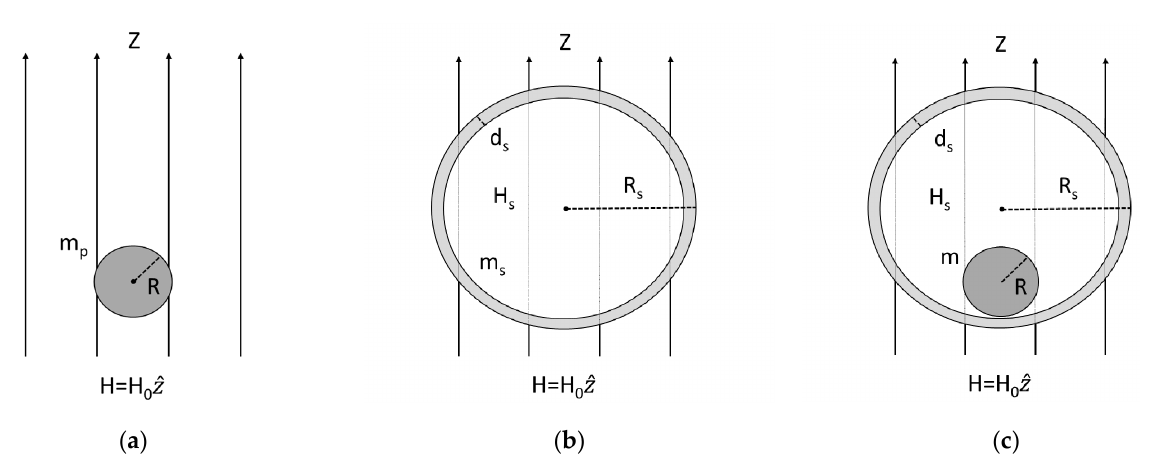
Figure 1. The geometry of spherical ( a ) conductive object, ( b ) thin enclosure, and ( c ) hidden spherical object in thin enclosure using z-directed uniform magnetic field with H 0 amplitude. An inside conductive object has R radius and induces magnetic dipole ( m p ). The spherical shell has an R s outer radius and d thickness. The incident field ( H ) induces magnetic dipole ( m s ) and is scattered ( H s